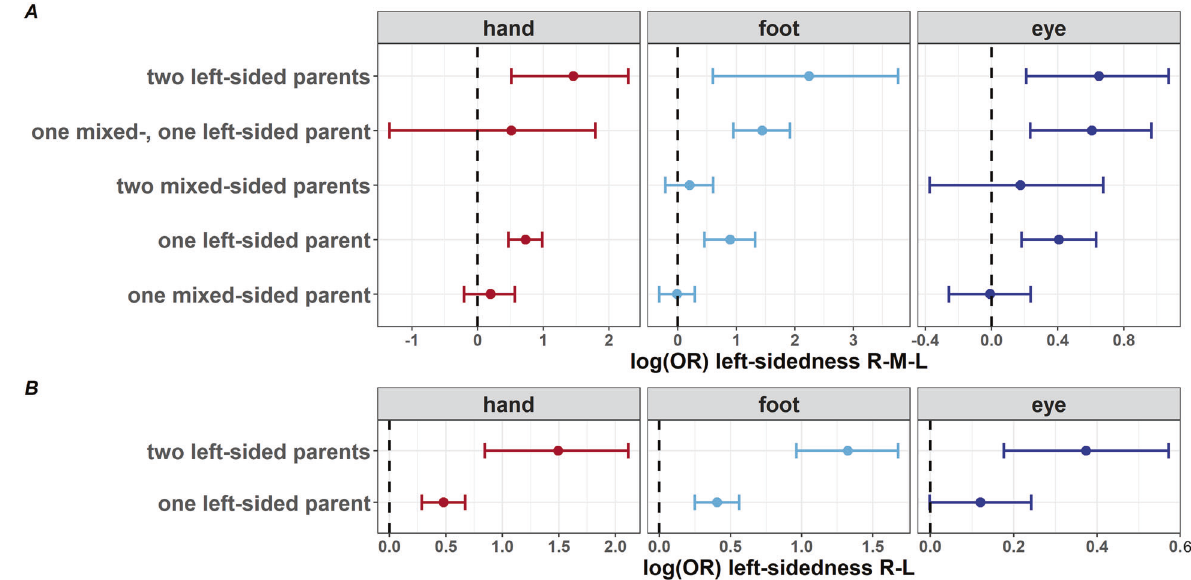
Fig. 1 Parental effects on child sidedness. ORs [95% CI], resulting from logistic regression